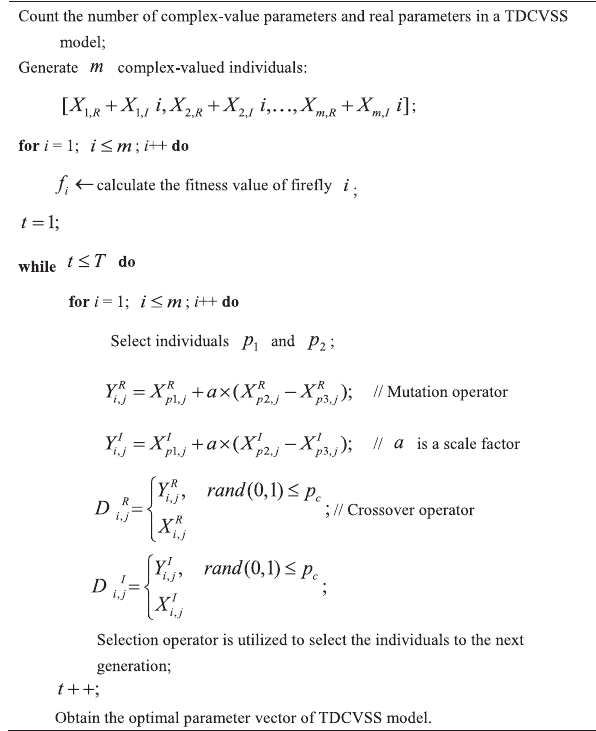
Algorithm 1. Parameter optimization of TDCVSS with complex- valued differential